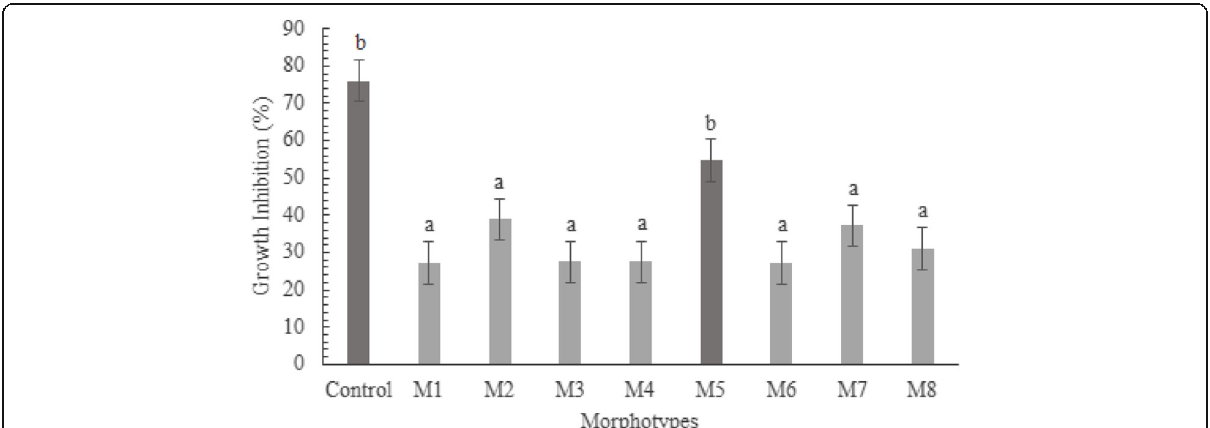
Fig. 1 In vitro antagonistic activity of the isolated yeast morphotypes (M1 to M8), against C. gloeosporioides . The one-way ANOVA ( F = 10.599; P < 0.05; df = 8) showed that M1 to M6 and M8 have significant differences with the control and M5 inhibition activity, which is specified with the letters “ a ” and “ b. ” The error bars indicate standard error